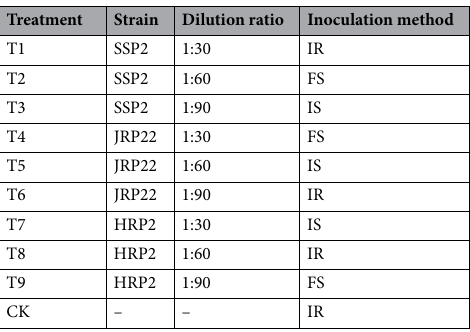
Table 1. L 9 (3 4 ) Orthogonal design of experiment. IR irrigation of the rhizosphere, FS foliar spray, IS irrigation of the rhizosphere + foliar